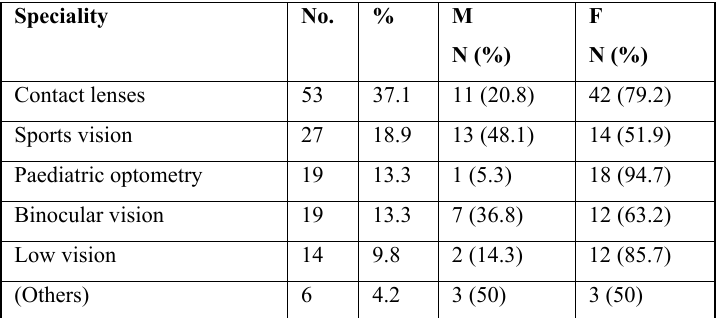
Table 14: The speciality areas of Optometry that the respondents indicated that they were interest